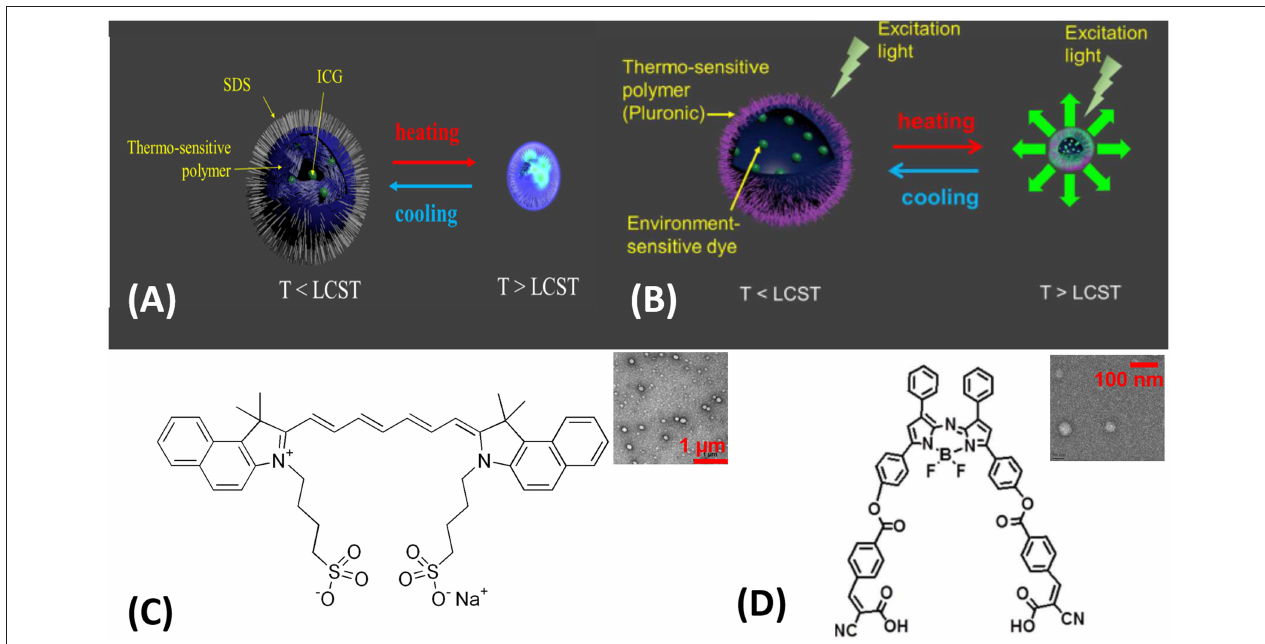
FIGURE 5 | Two classes of USF contrast agents: (A) ICG-encapsulated PNIPAM NPs (Pei et al., 2014). Thermo-sensitive polymer: PNIPAM; environment-sensitive dye: ICG. (B) ADP-CA-encapsulated Pluronic micelle ( Cheng et al., 2016). Thermo-sensitive polymer: Pluronic polymer; environment-sensitive dye: ADP-CA. Chemical structures of ICG (C) and ADP-CA (D) . LCST: lower critical solution temperature. Insert (C) Transmission electron microscopy (TEM) image of (A) , scale bar: 1 µ m; Insert (D) TEM image of (B) , scale bar: 100nm. Reproduced with permission. Copyrights 2014 © Springer Nature and 2016 ©